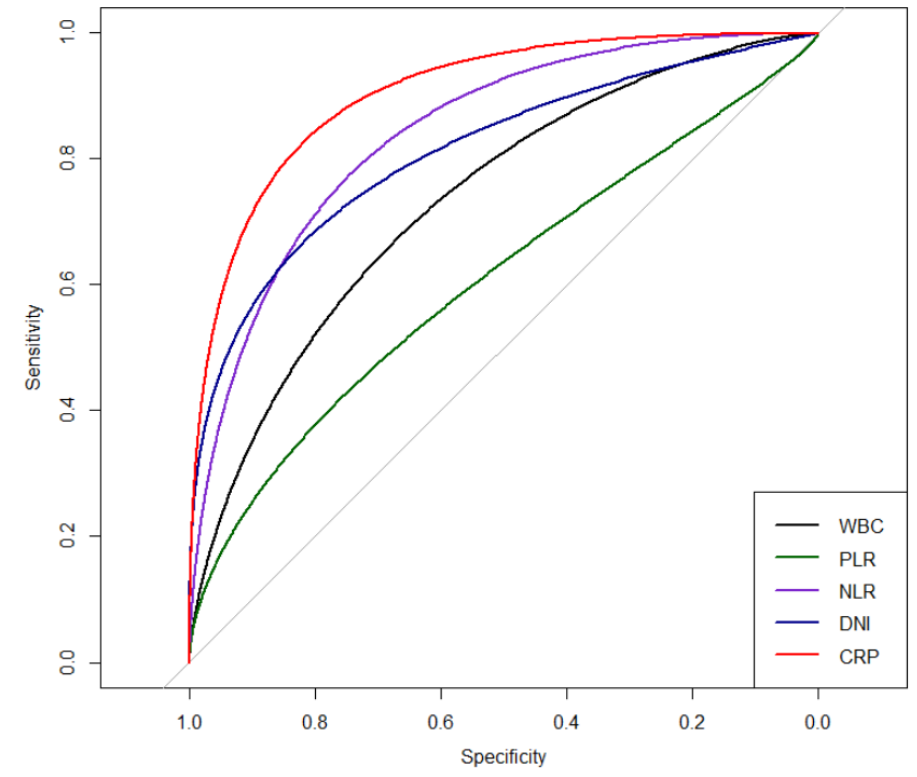
Figure 2. ROC curve of inflammatory markers. WBC: white blood cell; PLR: platelet–lymphocyte